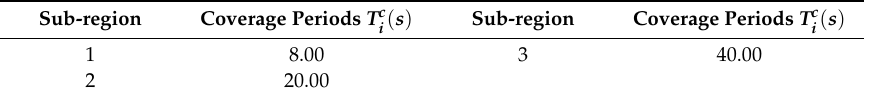
Table 1. Coverage periods for each sub-region.